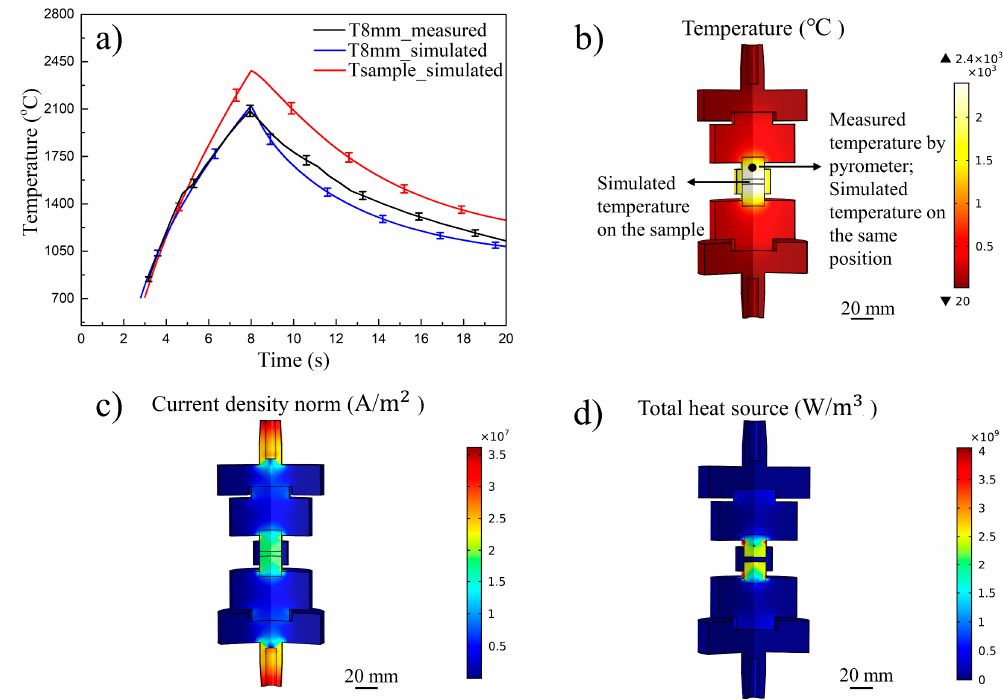
Figure 4. Electrothermal FEM distribution at the end of 6 kA discharge of sample UFS 2, ( a ) temperature profile, ( b ) temper- ature distribution, ( c ) current density distribution and ( d ) volumetric heat source.